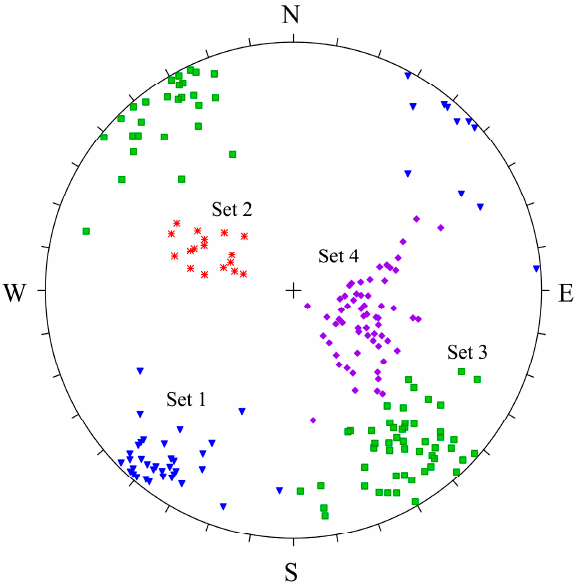
Figure 3. The poles of the fracture orientations on the upper hemisphere for each fracture set.